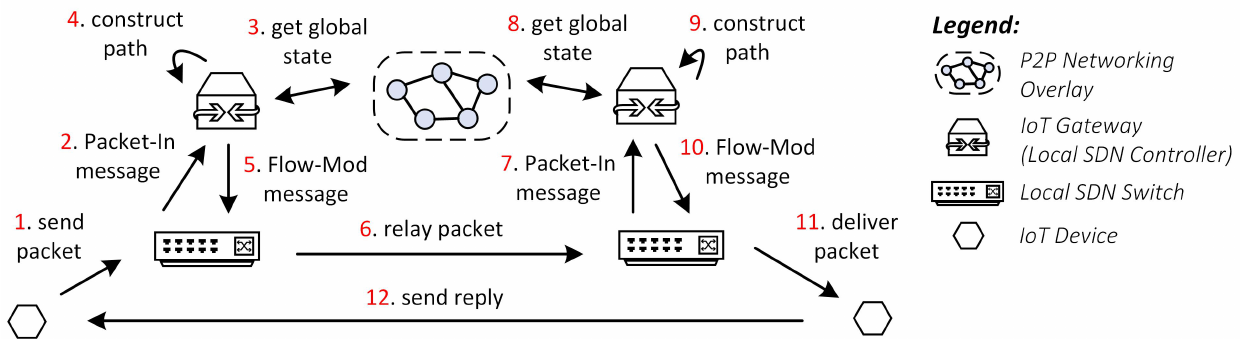
Figure 5. Delivering IoT data traffics across IoT domains, highlighting a possible networking workflow in our